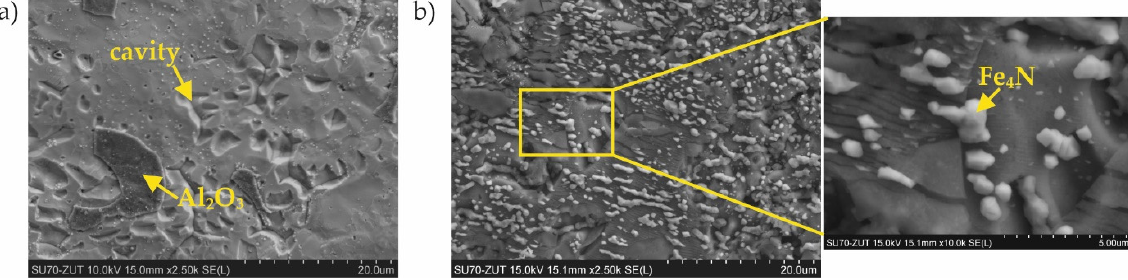
Figure 9. Microstructure of the sample with the coating manufactured in 800 °C, 2 h with additional oxidation in 1000 °C during 5 min after ( a ) 124 h and ( b ) 200 h of nitriding.